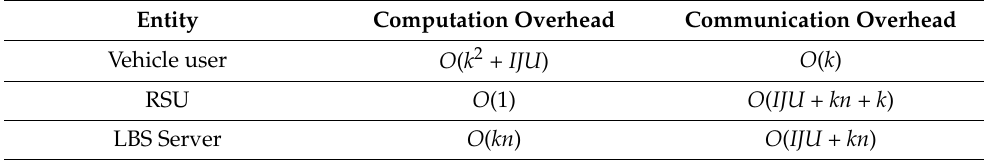
Table 1. Performance of proposed RR-DLS method.